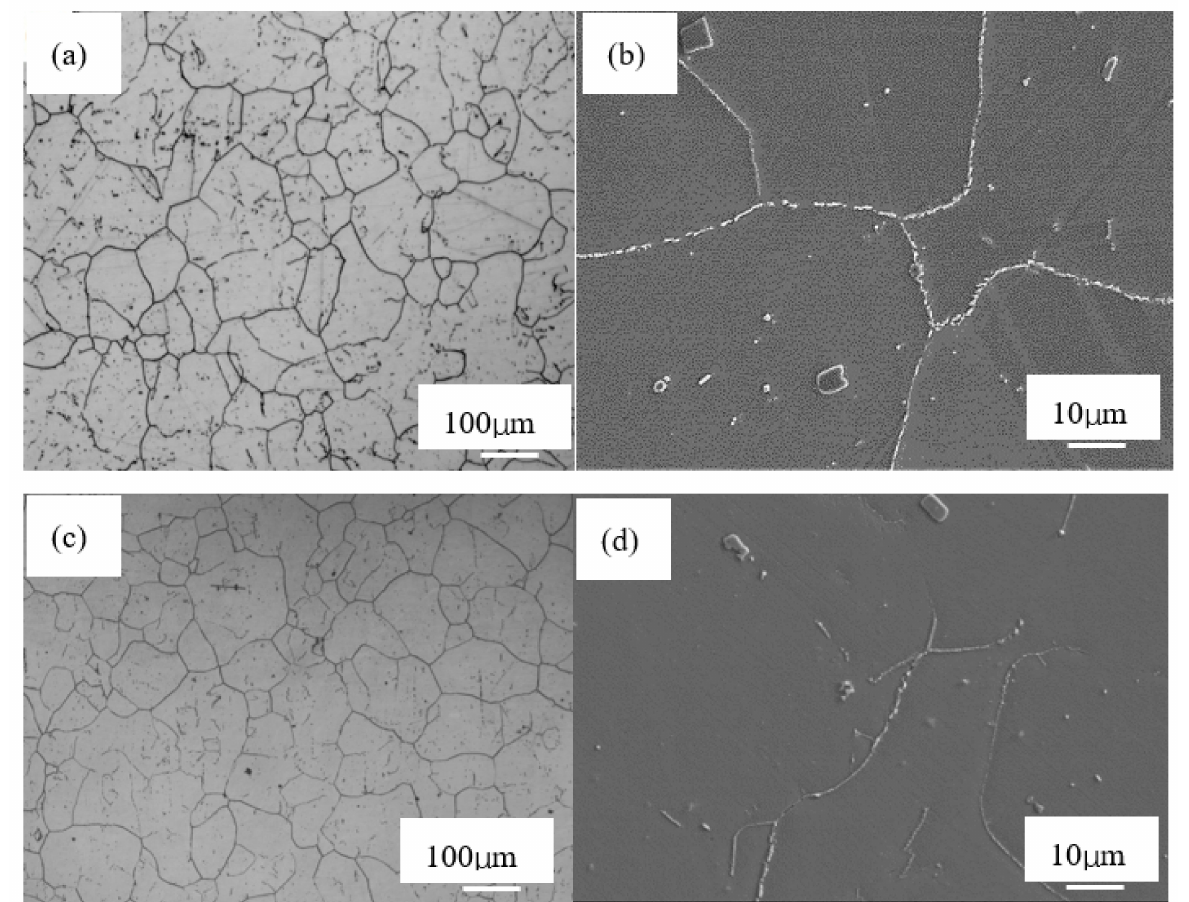
Figure 1. Microstructures of test alloys before long-term exposure. ( a , b ) Waspaloy; ( c , d )